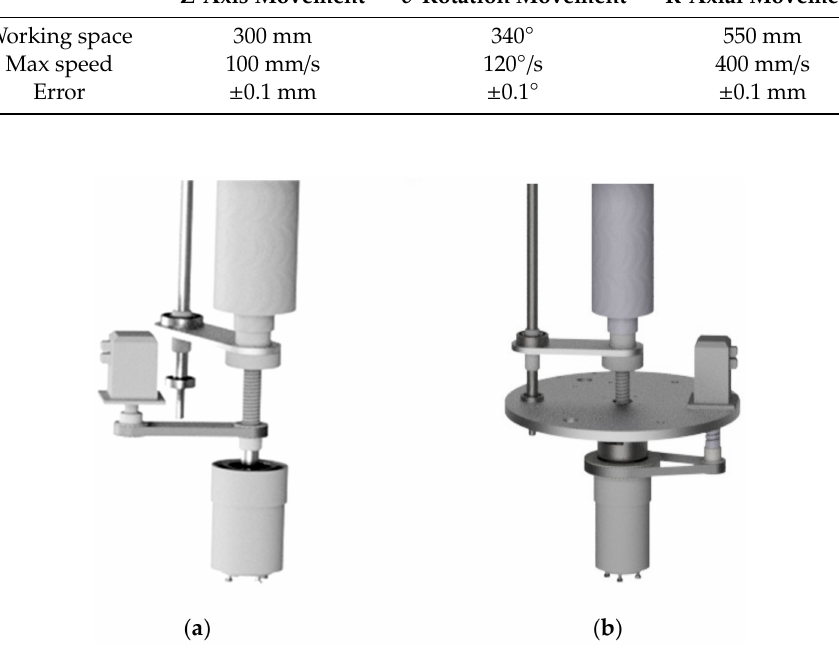
Figure 4. Description of movement for the proposed platform: ( a ) linear motion along the Z-axis, ( b ) rotational θ